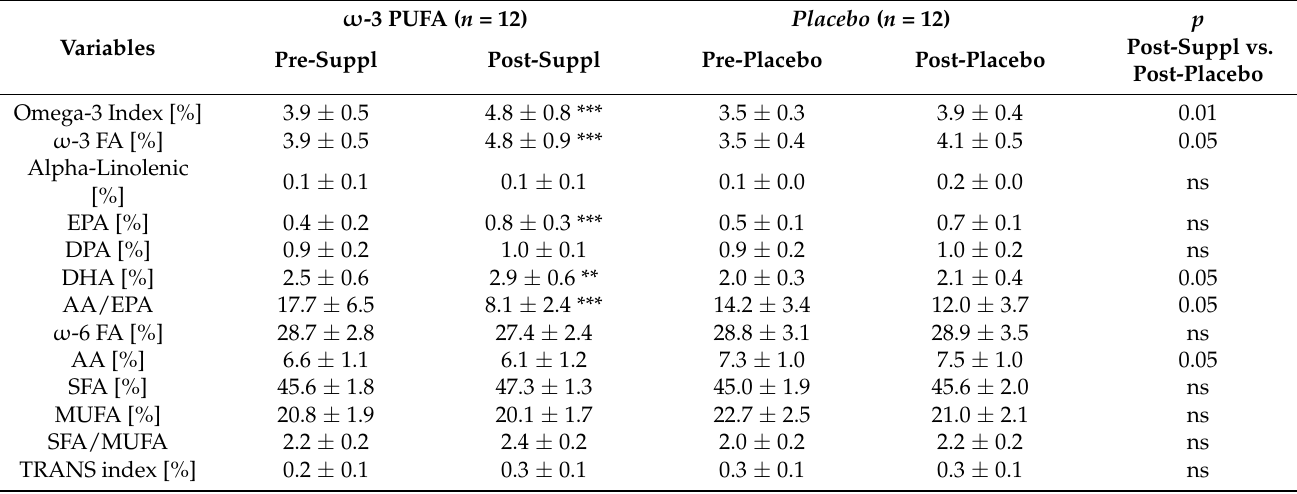
Table 3. Omega-3 Index and other fatty acids content in the erythrocyte membranes in the supplemented group ( ω -3 PUFA) and placebo group (Placebo) (mean,